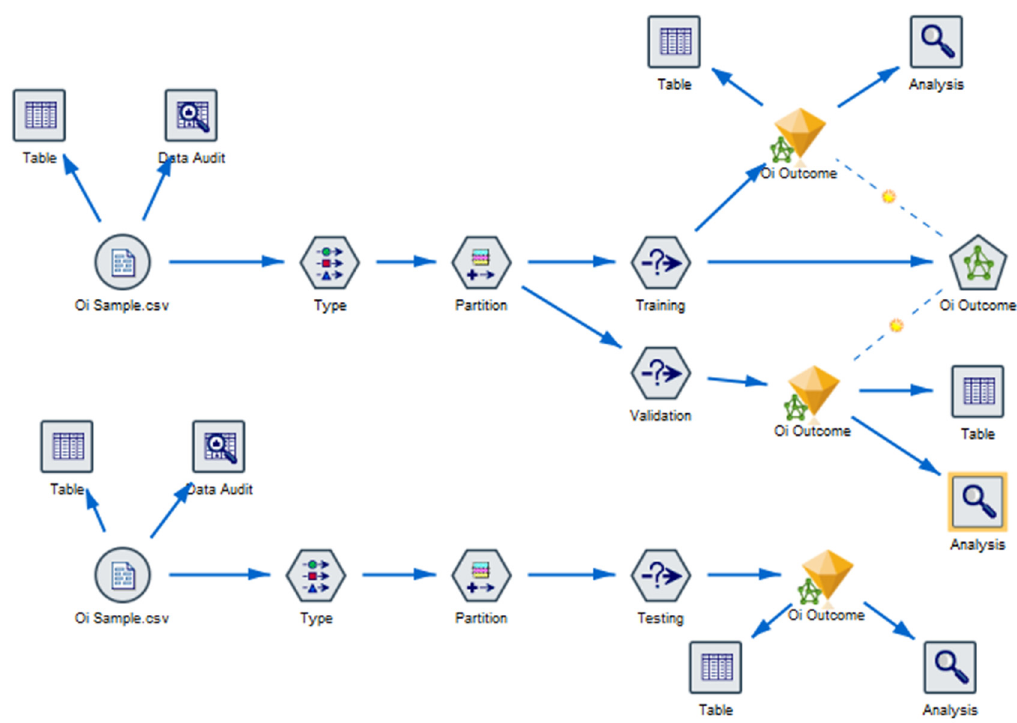
Figure 5. The ANN topology determination stream developed with IBM SPSS Modeler.